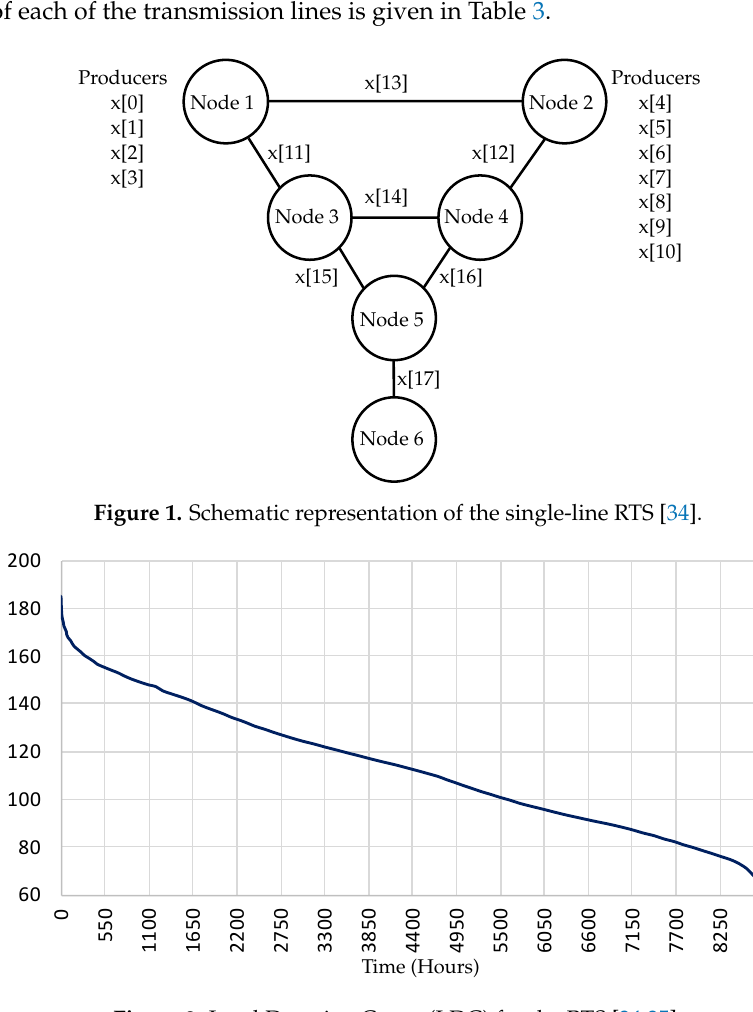
Figure 2. Load Duration Curve (LDC) for the RTS